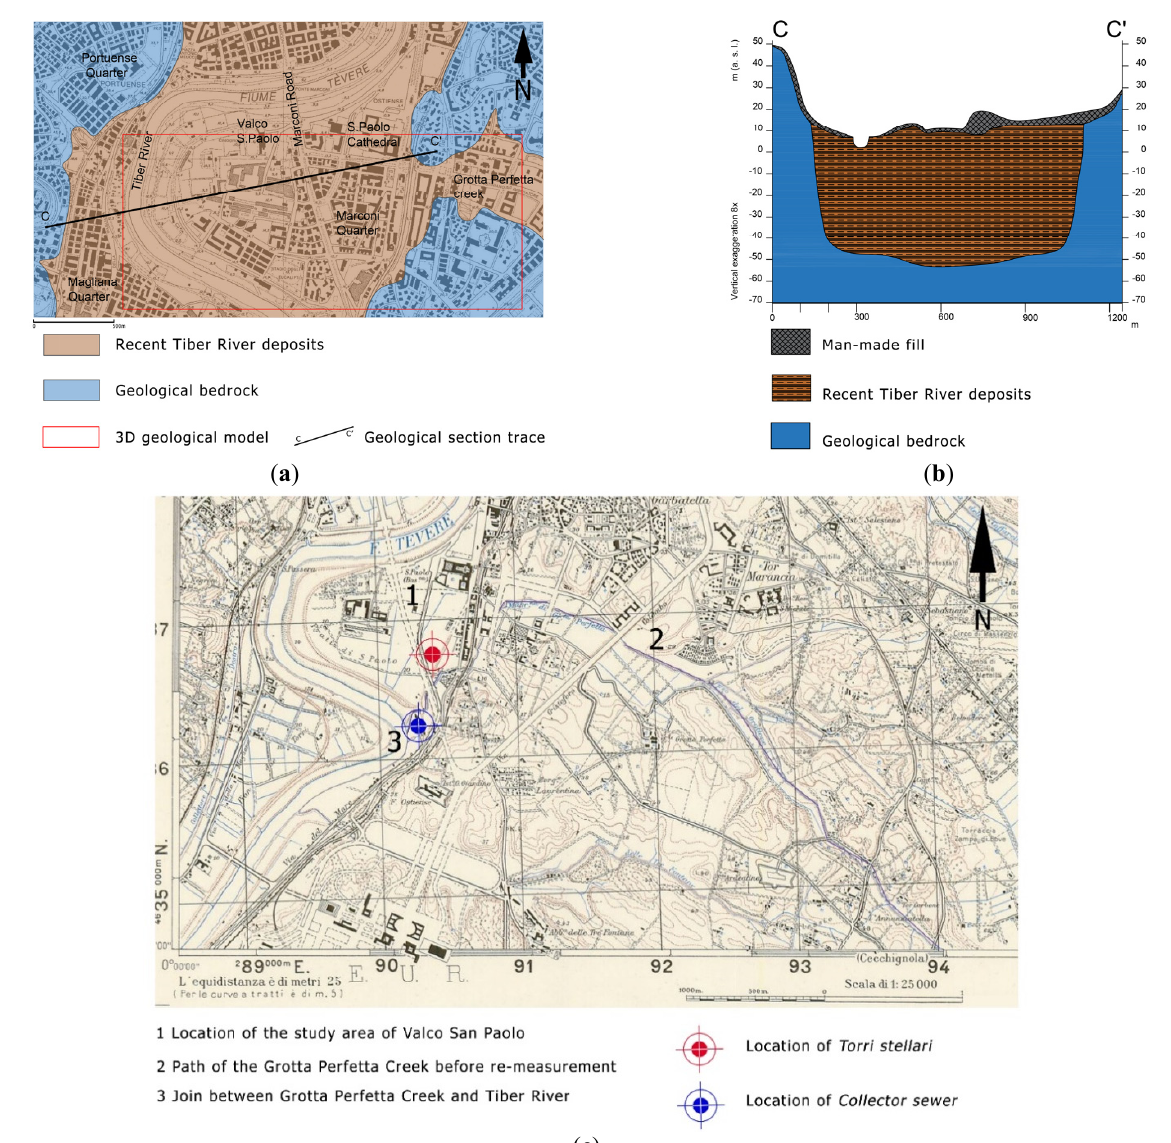
Figure 5. ( a ) Geological map of the Tiber valley at Valco San Paolo (modified from Bozzano et al. [51]); ( b ) geological cross-section of area of Valco San Paolo (modified from Bozzano et al. [51]), the trace is shown in ( a ); ( c ) extract from the IGM topographic map of Rome F ◦ 150, IV SW, 1:25,000 (1949).